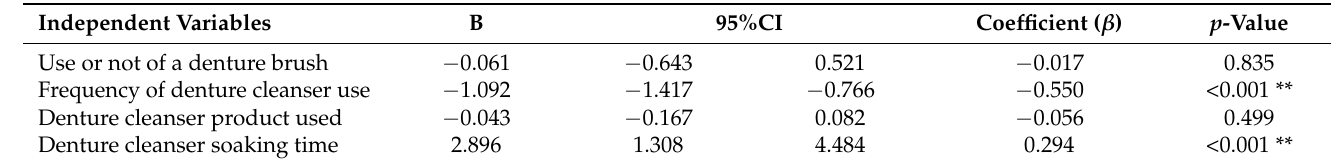
Table 5. Multivariable linear regression analysis of the number of Candida spp. and four sur- veyed